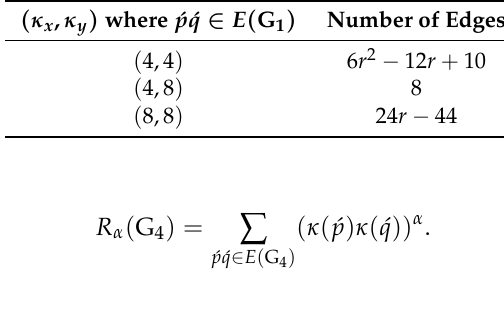
Table 4. Edge partition of chain hex-derived network of type 3, CHDN 3 ( r ) based on degrees of end vertices of each